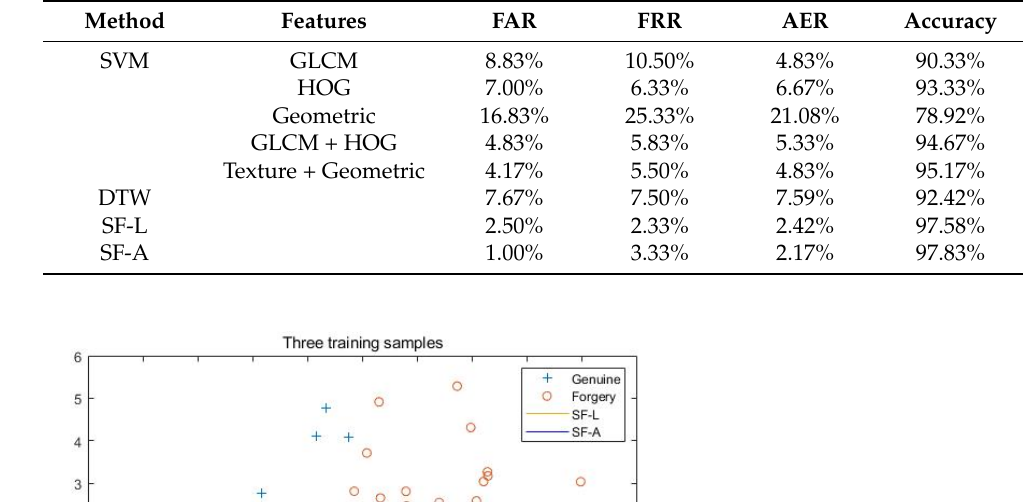
Table 5. The result of five training samples.